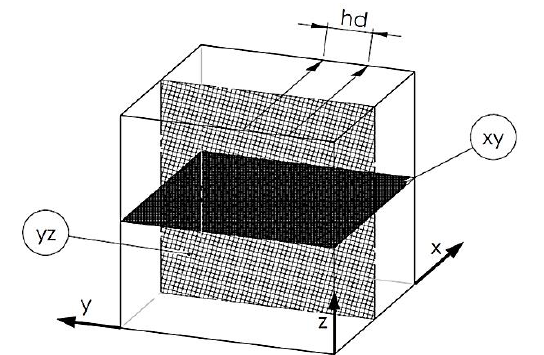
Figure 1. Cubic samples with the two main testing surfaces: XY: plane parallel to the building platform surface, YZ: plane perpendicular to the building platform surface, hd: hatching distance, which is the distance between the exposure lines, Z:direction of growth [32].